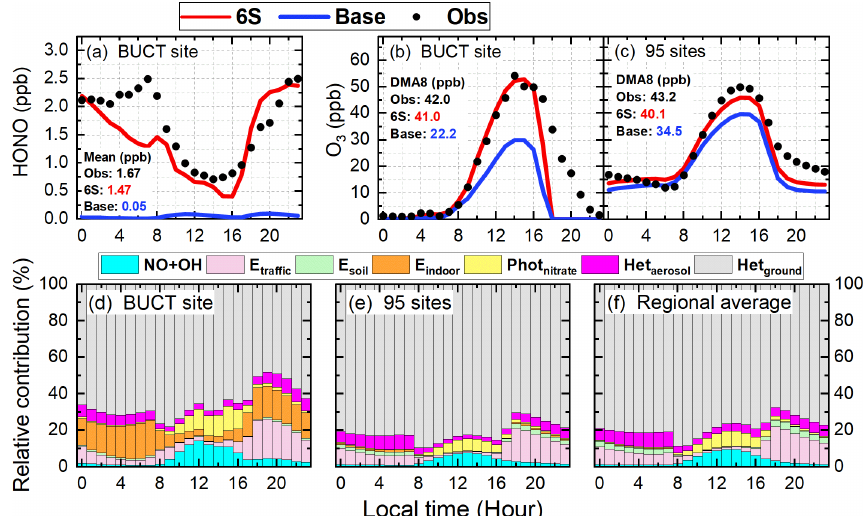
Figure 3. Comparison of diurnal mean simulations (Base and 6S cases) and observations of HONO during the study period (a) and O 3 during the first two haze events at the BUCT site (b) and O 3 averages at the 95 NCP monitoring sites during the study period (c) ; the relative contributions of each of the six potential HONO sources and the reaction of OH with NO to surface HONO concentrations for the 6S case at the BUCT site (d) , at the 95 monitoring sites (e) , and in the whole NCP region (f) . The calculated 24h mean HONO concentrations and DMA8 O 3 concentrations are given in panels a – c